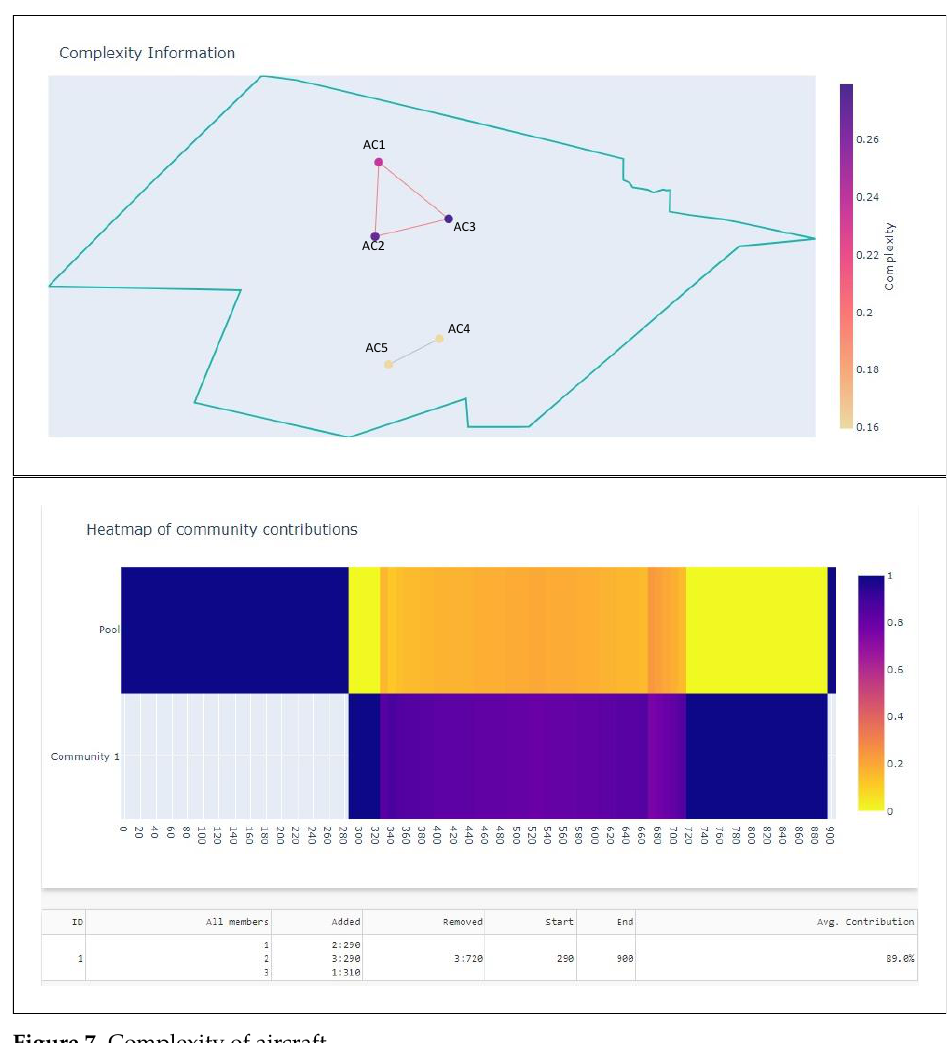
Figure 7. Complexity of aircraft.